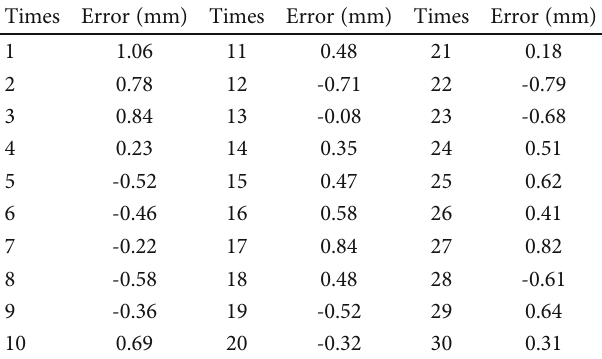
Table 10: Positioning error of hydraulic rod at 1.6 m